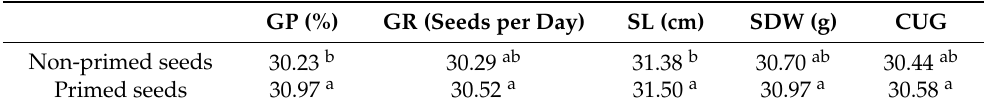
Table 4. Effects of priming on the reduction of GR and enhancement of morphological traits per unit of salinity (EC dSm − 1 ) above the threshold value. GP (%) GR (Seeds per Day) SL (cm) SDW (g) CUG Non-primed seeds 30.23 b 30.29 ab 31.38 b 30.70 ab 30.44 ab Primed seeds 30.97 a 30.52 a 31.50 a 30.97 a 30.58